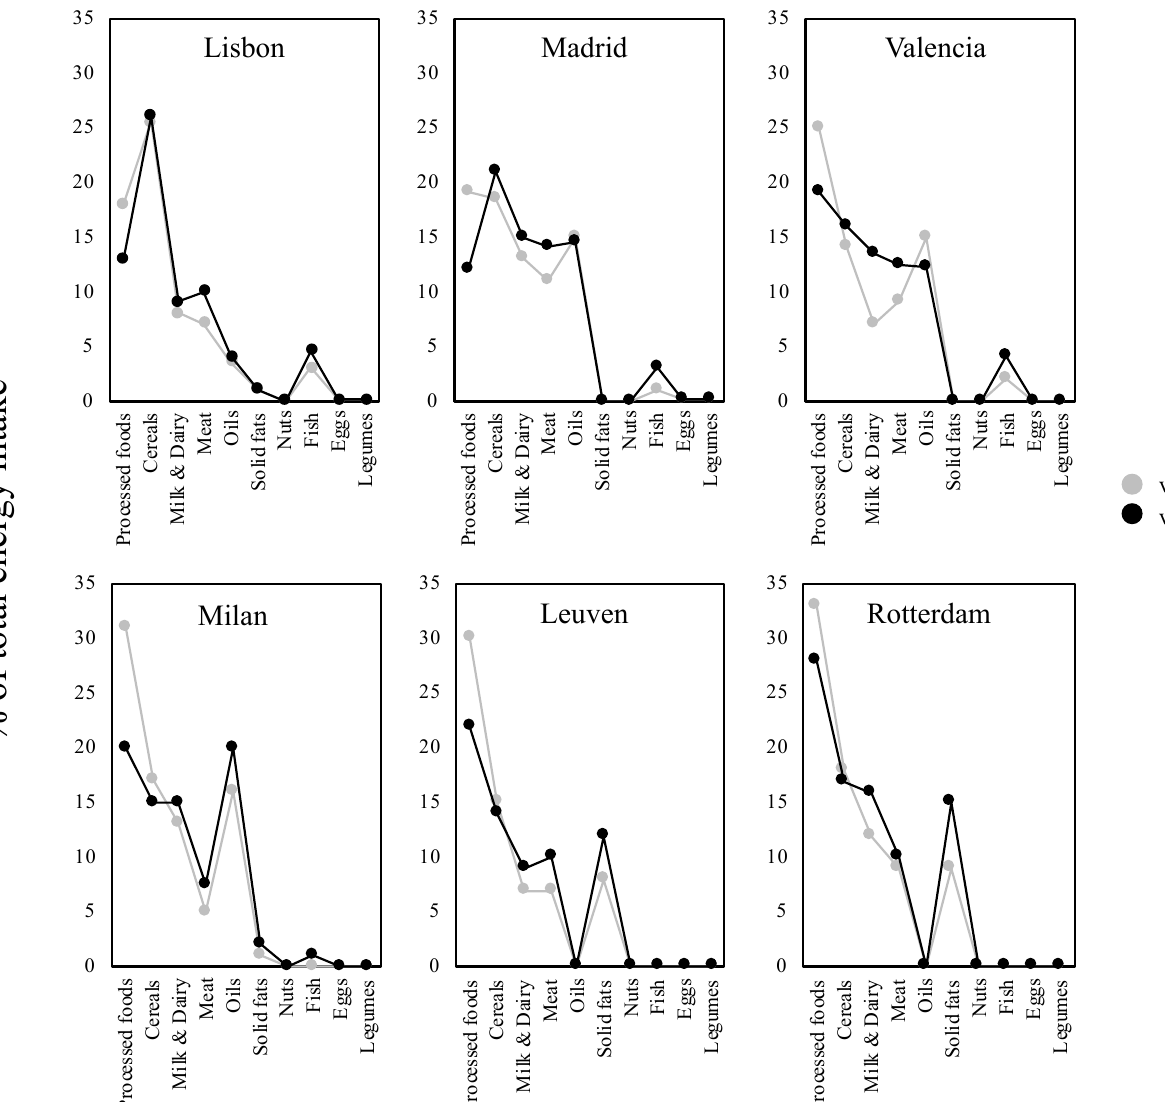
Figure 4. Relative contribution of food groups to total daily energy intake at study baseline (v1) and after the intervention (v3) of the clinical trial in the six European participating centres. Original to this manuscript.